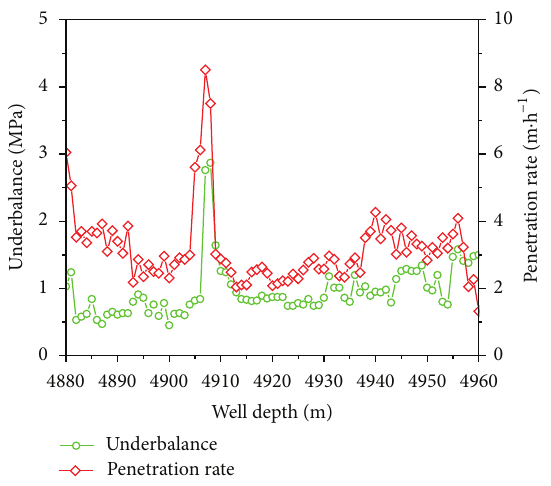
Figure 15: Underbalance and penetration rates profiles.